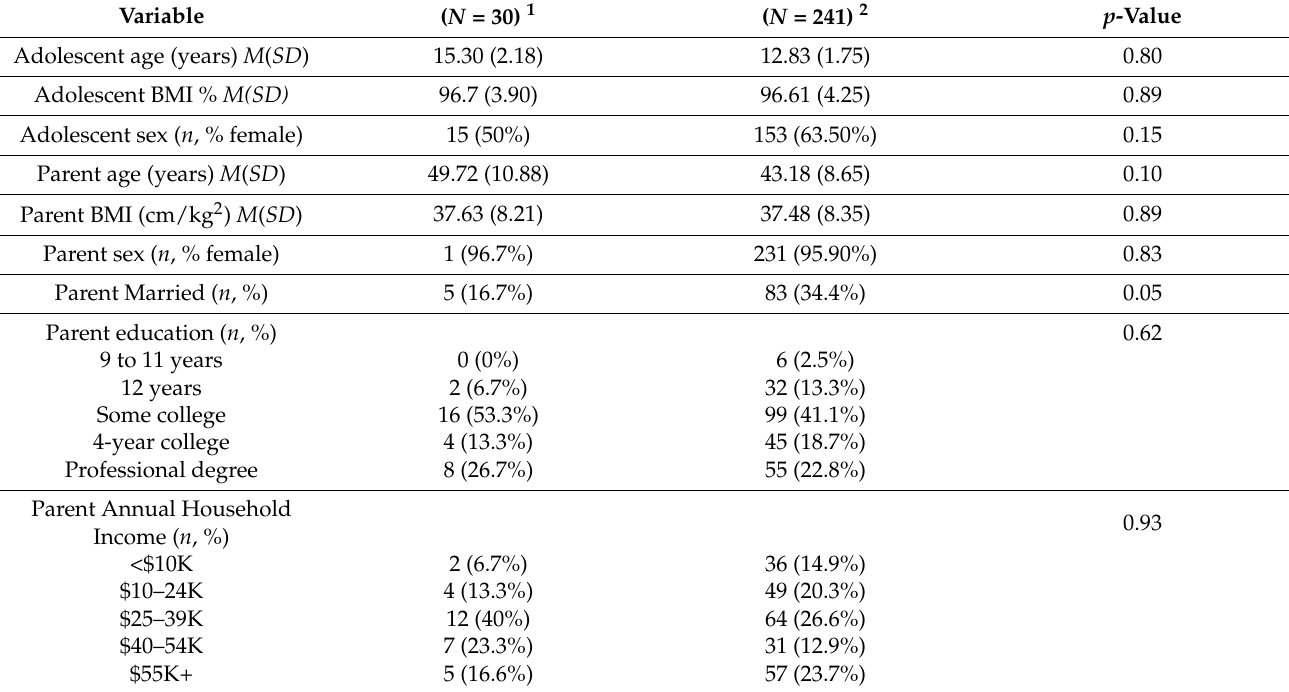
Table 2. Descriptive data for the subsample 1 & the full FIT sample 2